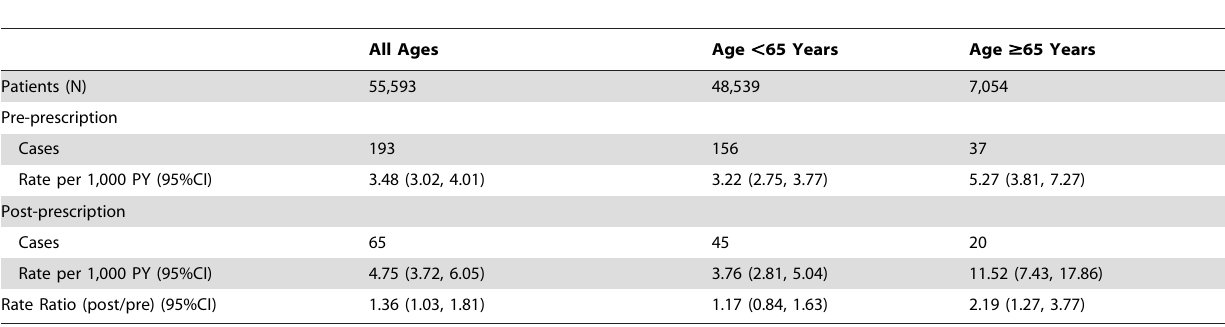
Table 1. Rates of myocardial infarction per 1,000 persons per year (PY) in men under age 65 years and those age 65 years and older, in pre- and post-prescription intervals for an initial prescription for testosterone therapy rate ratios (RR) and 95% confidence intervals